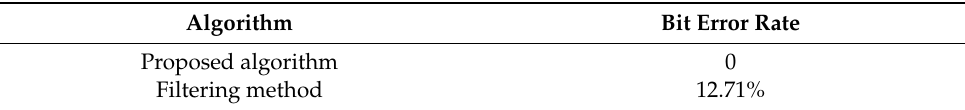
Table 2. BER of the proposed algorithm and filtering (weak wind).